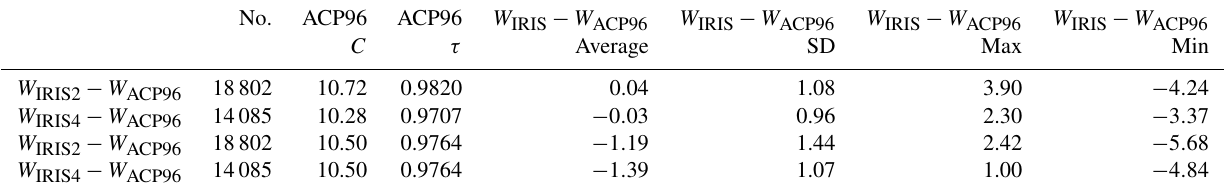
Table 4. The statistics of ( W IRIS − W ACP96 ) using ε c = 0 . 0225 and γ = 8 . 4 from March to November 2020, for the pairs of C and τ that minimised the mean difference of W IRIS − W ACP96 . The difference statistics using the average C and τ of the IRIS2 and IRIS4 results are also given in the last two rows of the table. No. ACP96 ACP96